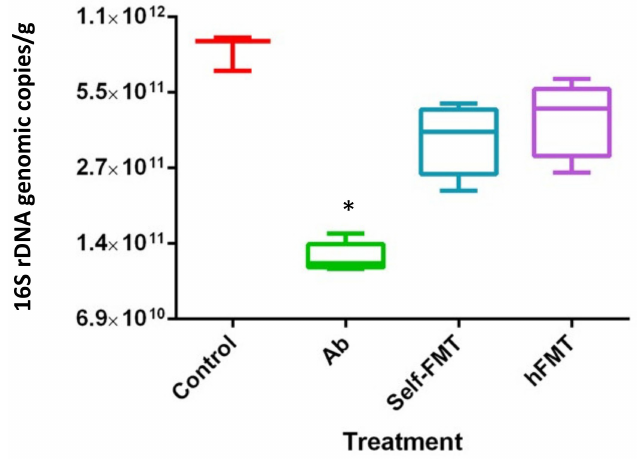
Figure 2. Total bacterial 16S rDNA quantification by qPCR . The 16S rDNA genomic copies/g of stools are presented for the control mice, Ab-treated mice and mice subject to self-FMT and hFMT, respectively. Ab-treated mice had a significantly lower amount of 16S rDNA copies than the other three groups ( p < 0.05), indicated by an asterisk (*). Ab, antibiotic; hFMT, human fecal microbiota transplantation; self-FMT, self-fecal microbiota transplantation.